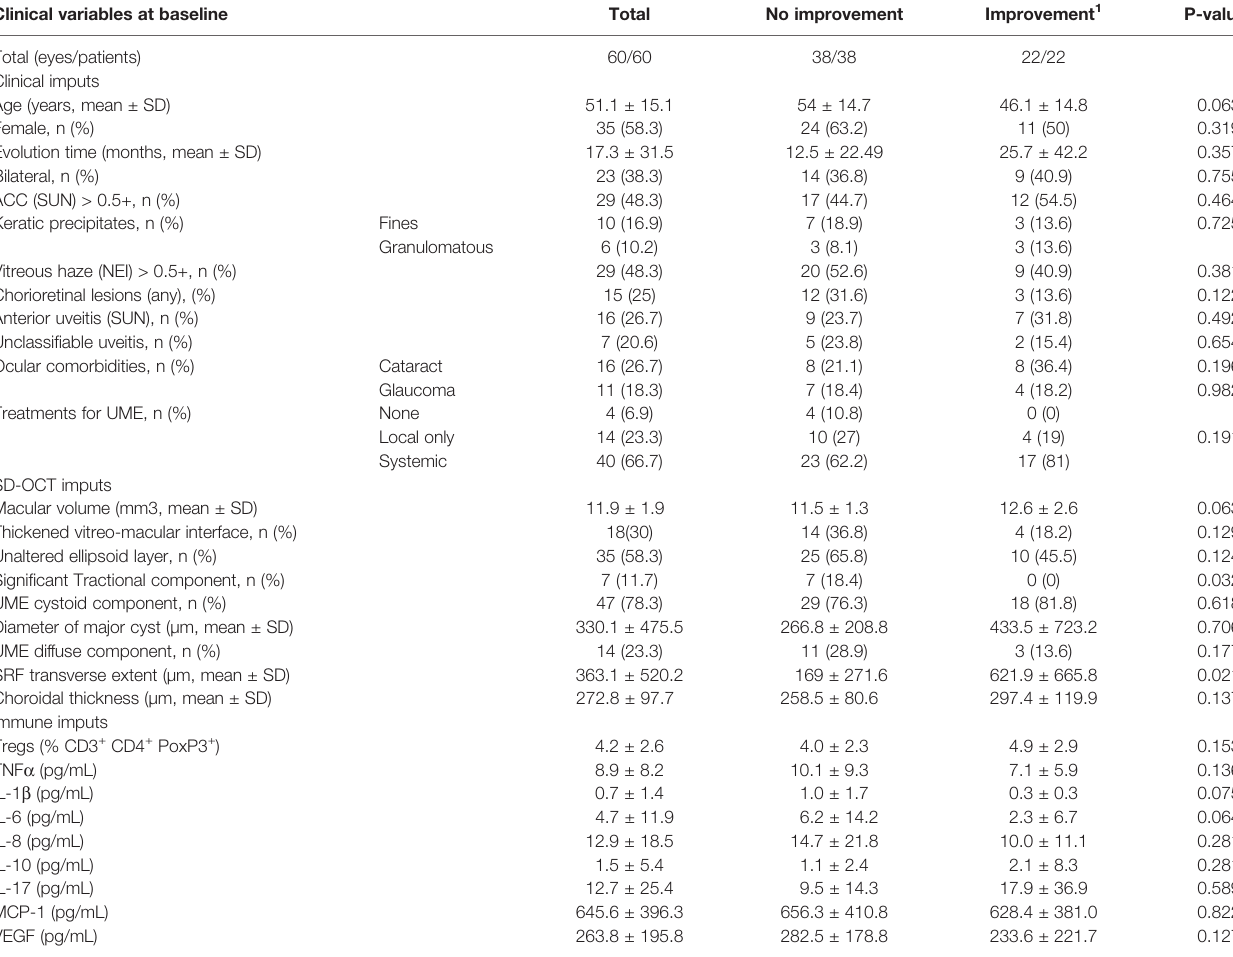
TABLE 3 | Clinical variables in UME with and without anatomical improvement. Clinical variables at baseline